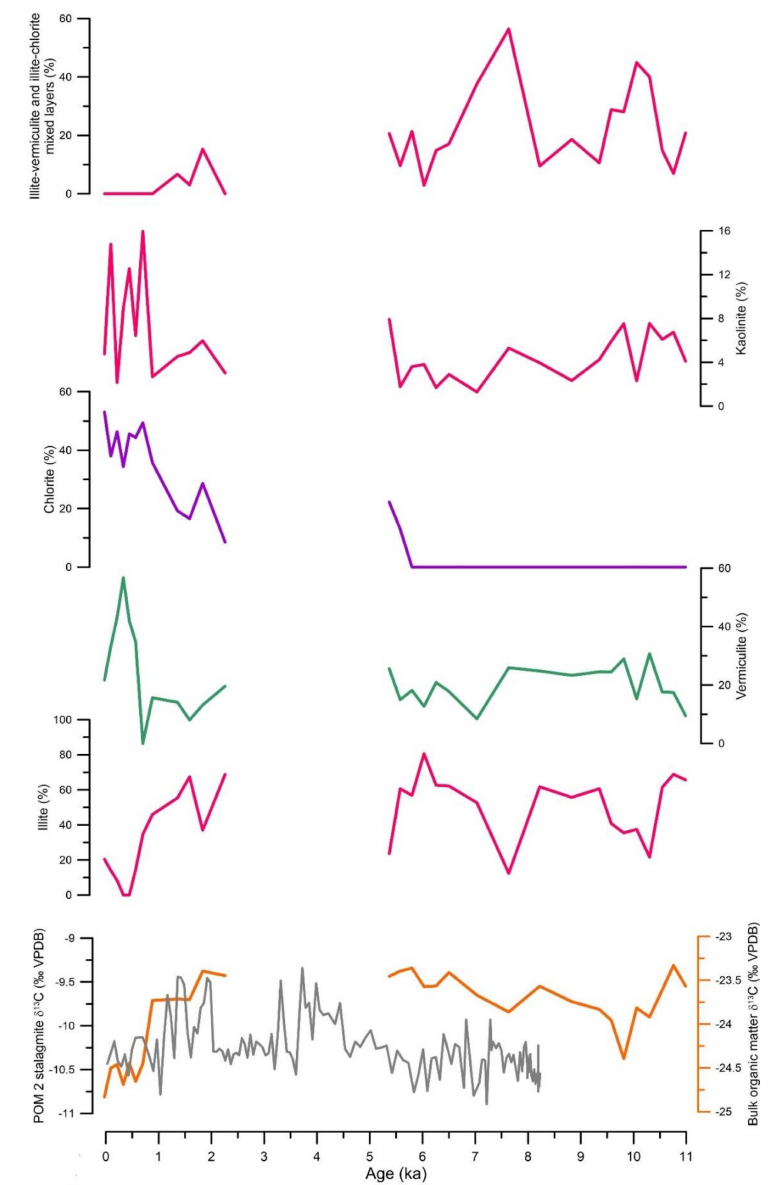
Figure 10. Variation of clays and organic matter δ 13 C values over time: illite–vermiculite and illite–chlorite mixed layers, kaolinite, chlorite, vermiculite, illite, and δ 13 C